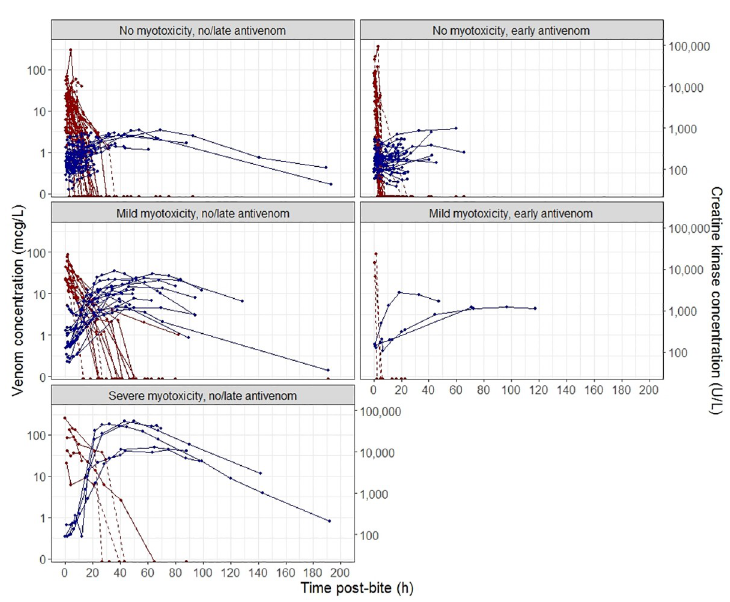
Fig 1. Plots of timed venom concentration (mcg/L) [red lines] and creatine kinase (CK) concentration (U/L) [blue lines] following envenomation by red-bellied black snakes. Solid lines are venom concentrations pre- antivenom and dashed lines are the venom concentrations post-antivenom. Patients data were categorised into three groups based on measured peak CK concentration: (a) no myotoxicity (CK < 1000 U/L); (b) mild myotoxicity (1000 U/L < CK < 10,000 U/L); and (c) severe myotoxicity (CK > 10,000 U/L). Plots on the left panel are for patients that received no or late antivenom, and on the right are those that received early antivenom (within 6 hours).